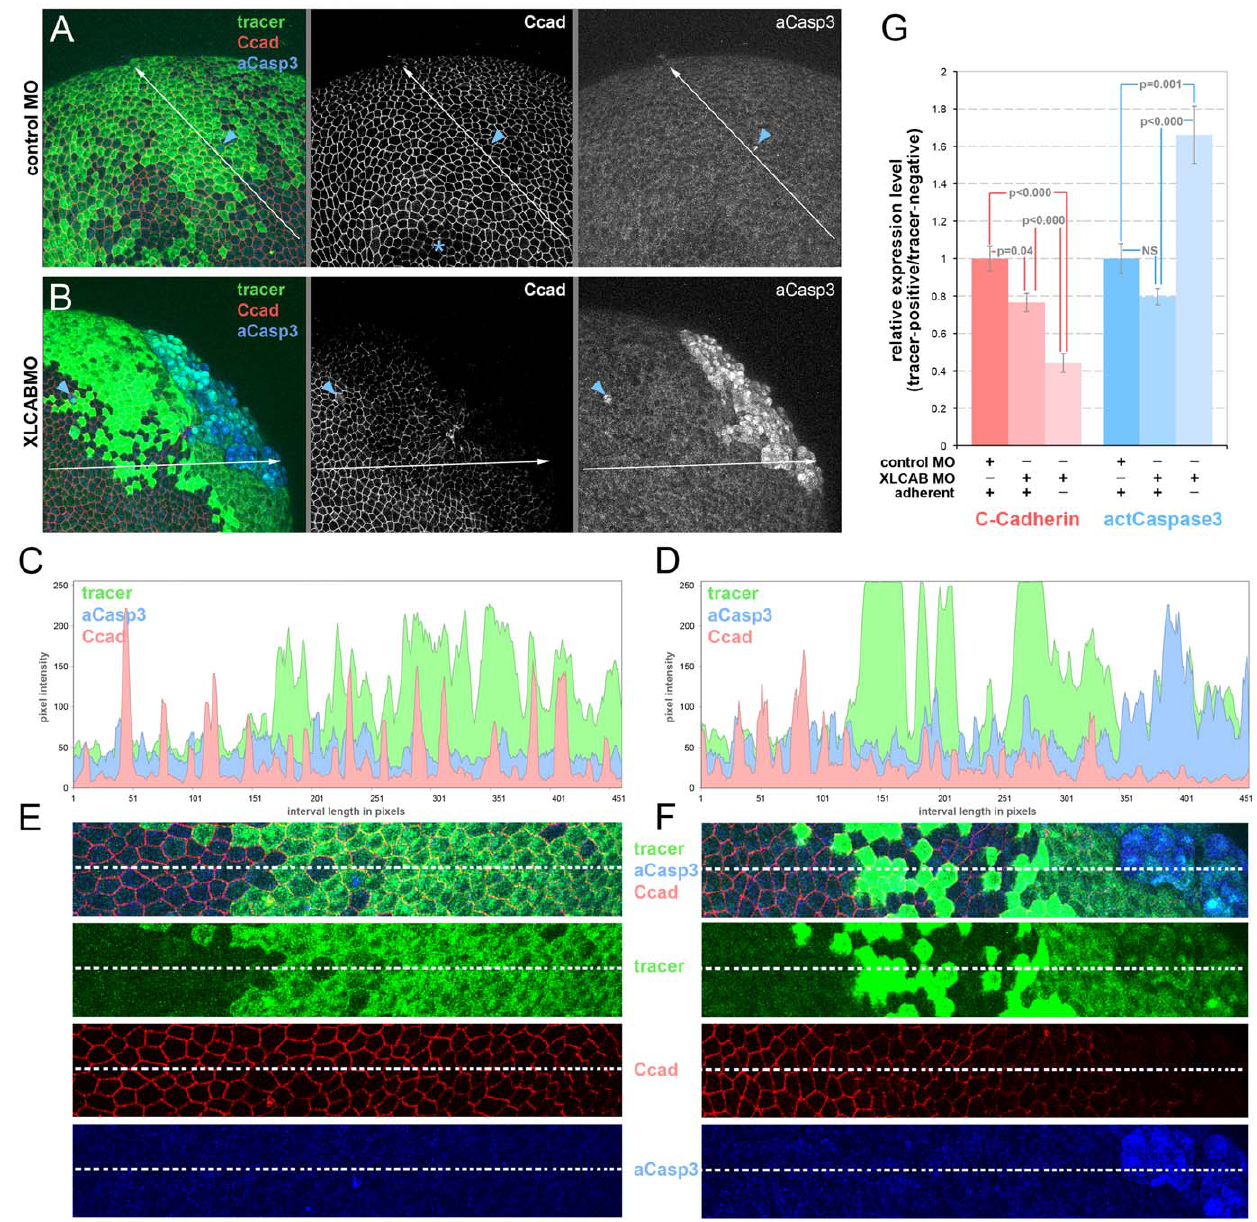
Figure 4. Cadherin junctional complex deficiency is the primary response to CRIM1 loss-of-function. ( A–B ) Embryos were injected with either standard control MO or 15 ng each XLCAB MOs with dextran tracer (green), fixed at stage 13 and labeled for C-cadherin (Ccad) and activated caspase 3 (aCasp3). In (A) the asterisk indicates a region where labeling in the apical junctional complex was not imaged due to the optical sectioning plane. In (A and B), the blue arrowheads indicate isolated dying cells labeled positive for activated caspase 3. ( C–D ) Three-channel histograms indicating pixel intensity along a line interval of 450 pixels in control MO (A and C) and XLCAB MO (B and D) injected embryos. ( E–F ) Magnified images of regions along the line interval in (A and B) with color channel merge (top) and separated color channels corresponding to different labels as indicated. ( G ) Quantification of relative expression levels of C-cadherin and activated Caspase 3 in standard control MO and XLCAB injected embryos. The expression levels are determined by the ratio of average pixel intensities over 150-pixel intervals in tracer-positive regions and tracer- negative regions within the same embryo. In XLCAB injected embryos, relative expression levels were measured over intervals placed exclusively in tracer-positive, adherent regions or tracer positive, non-adherent regions (n=8 for all categories). doi:10.1371/journal.pone.0032635.g004 mutants of V5 tagged CRIM1 could form complexes with mutants carrying C-terminal V5 tags (Fig. 7A) and determined CRIM1-FL-ED (Fig. 7B, center left). These data indicate that whether this would coimmunoprecipitate (co-IP) from HEK293 CRIM1 can form complexes where multiple CRIM1 molecules cells. According to immunoblots with appropriate antibodies, all are present. These data also show that an N-terminal region proteins expressed well (Fig. 7B, left panels) and the V5 tagged containing the IGFBP-like domain is sufficient for formation of proteins could also be efficiently IPd (Fig. 7B, far right). Anti-V5 IP this complex. followed by immunoblot with anti-FLAG showed all deletion